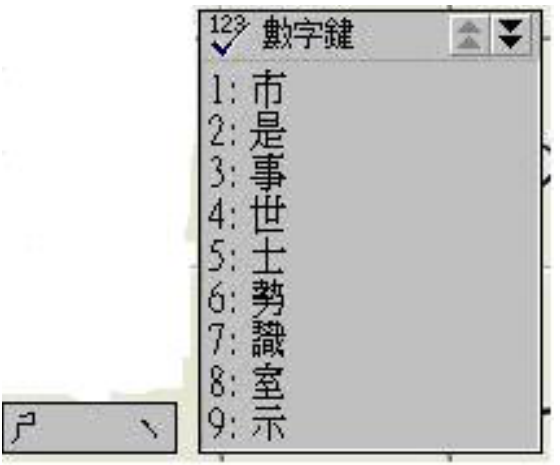
Figure 5. The homophones of an input phonetic symbol.